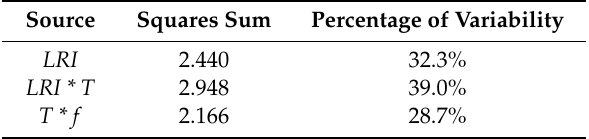
Table 11. Mg-Ti-Mg test. Percentage of variability of each factor on Ln Ra according to ANOVA. Source Squares Sum Percentage of Variability LRI 2.440 32.3% LRI * T 2.948